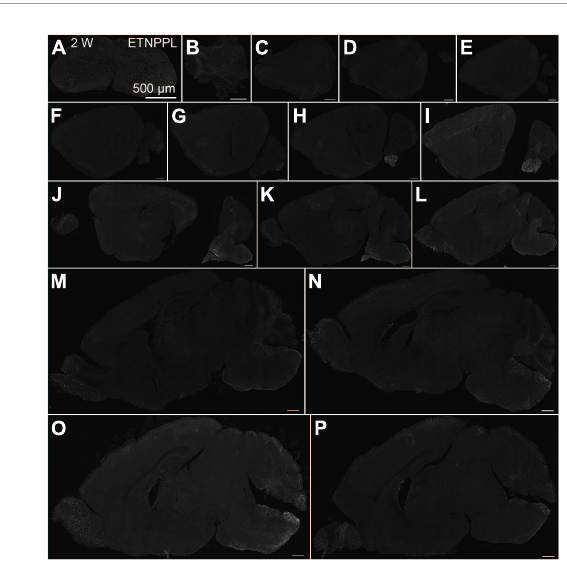
FIGURE5 Localization of ETNPPL in the whole brain in 2-week old mice. Coronal section of the cervical cord (A) , or parasagittal section (approximately 250 µ m interval) of the whole brain (B–P) of 2 W female mice are shown. White indicates the ETNPPL signal revealed by IHC. Scale bars: 500 µ m. The section images were appropriately rotated and cropped and the background was filled with black to minimize unnecessary space.